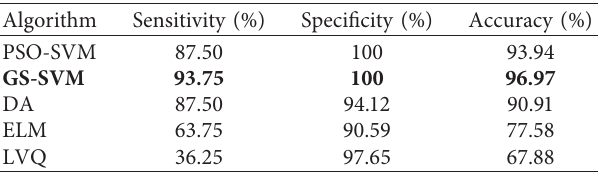
Table 2: Performance of PSO-SVM, GS-SVM, DA, ELM, and LVQ. Algorithm